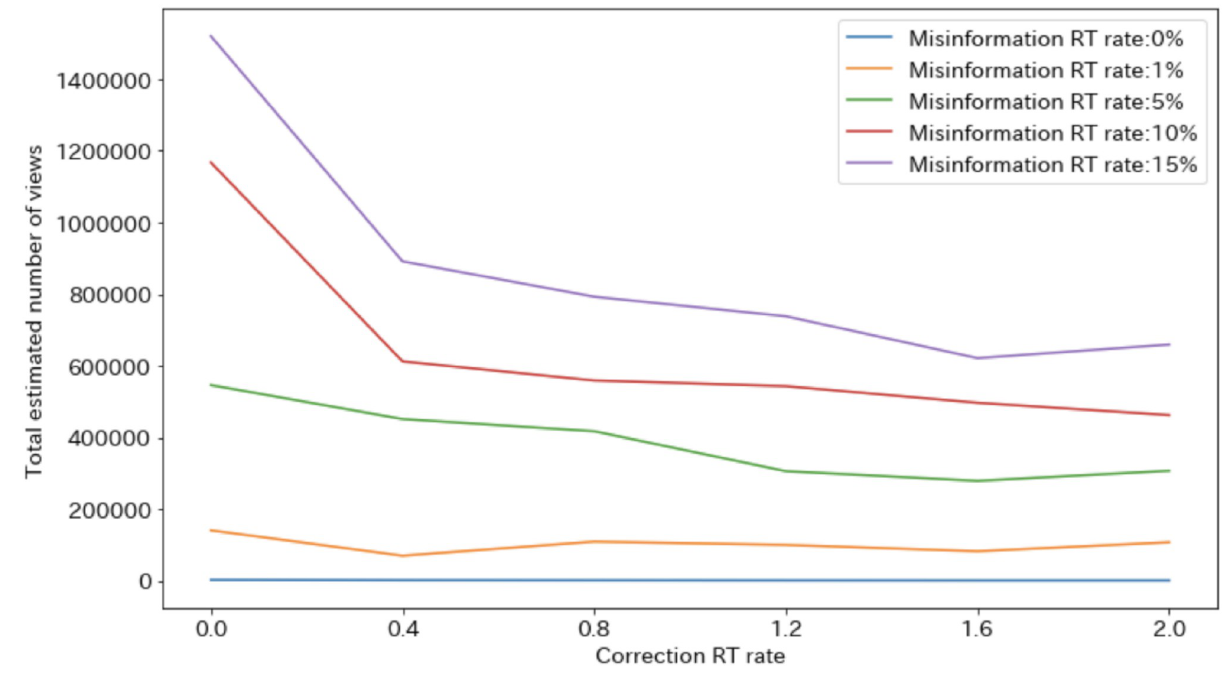
Fig 8. Total estimated number of views of misinformation-related tweets.